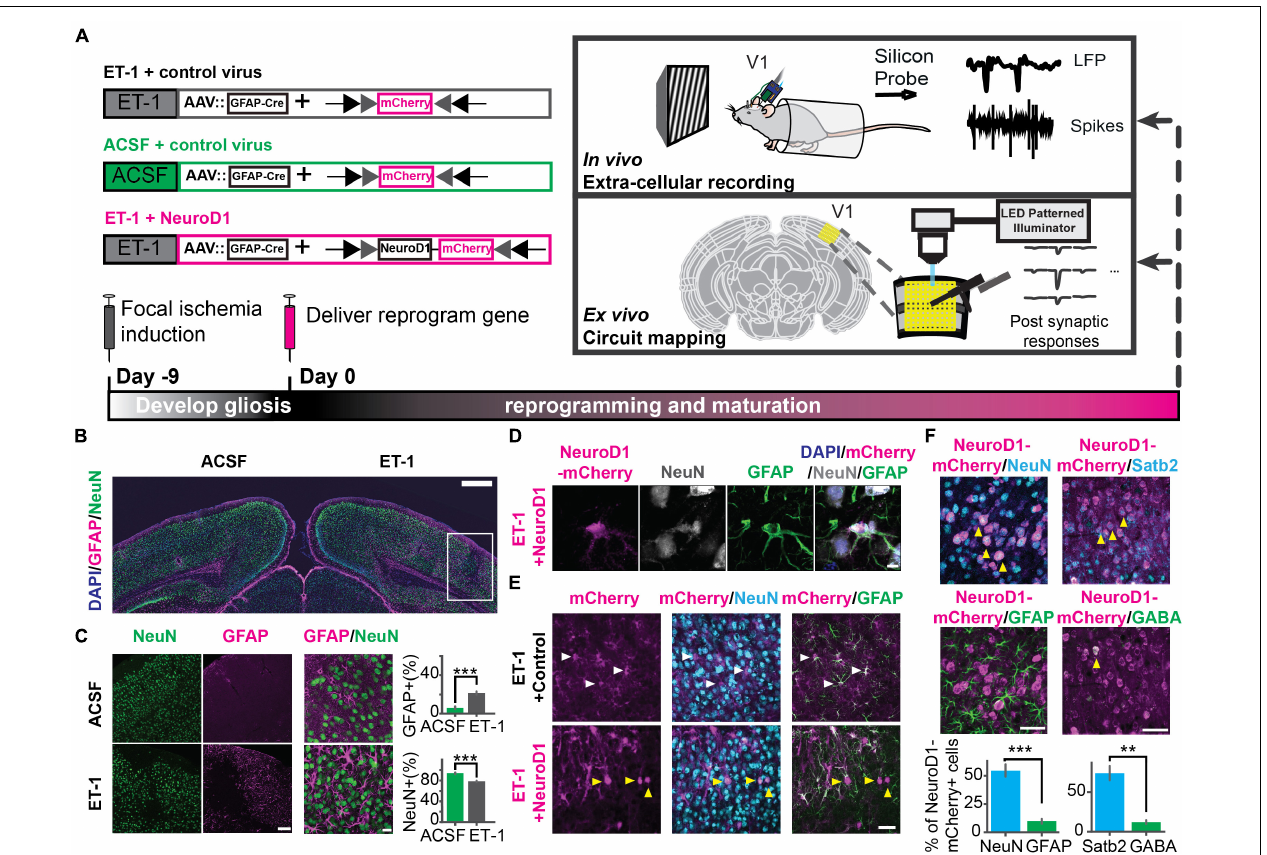
FIGURE 1 | Focal ischemic injury model and in vivo direct reprogramming in the primary visual cortex. (A) The schedule to induce focal ischemia by endothelin-1 (ET-1) injection and to reprogram astrocytes into neurons by injection of AAV-GFAP::Cre with AAV-FLEX-NeuroD1-mCherry (or with AAV-FLEX-mCherry as control). Following reprogramming, visual responses and local circuit connectivity of the primary visual cortex (V1) were assessed by in vivo extracellular recordings and ex vivo Channelrhodopsin-Assisted Circuit Mapping (CRACM). (B) Gliosis (GFAP, magenta) and neuronal loss (NeuN, green) at 9 days after 4 ug/ul ET-1 injection in the visual cortex. The box indicates injury site with gliosis and neuronal loss. Scale: 500 µ m. (C) Localized neuronal loss and gliosis at 9 days after 4ug/ul ET-1 injection. Scale left : 50 µ m. Scale right : 20 µ m. Right: Quantification of the percentages of GFAP-positive cells (top) and NeuN-positive cells (bottom). N ACSF = N ET − 1 = 3 mice, 9 slices. p = 4.12 × 10 − 4 , Mann-Whitney U test. (D) An example of NeuroD1-mCherry-positive cell undergoing a transition stage at 10 days after NeuroD1 delivery, expressing both GFAP and NeuN. Scale: 5 µ m. (E) mCherry positive cells co-stained with NeuN and GFAP at 10 days after viral injection. White arrows pointing to GFAP positive and NeuN negative cells. Yellow arrows pointing to GFAP negative and NeuN positive cells. Scale: 50 µ m. (F) NeuroD1-positive cells stained with NeuN, GFAP, Satb2, and GABA at 3 weeks after NeuroD1 delivery. Scale: 50 µ m. Bottom: Quantification of the ratios of marker positive cells. N NeuN / GFAP = 3 mice, 9 slices. p = 9.01 × 10 − 4 , Mann-Whitney U -test. N Satb2 / GABA = 2 mice, 6 slices. p = 5.08 × 10 − 3 , Mann-Whitney U -test. ** p < 0.01 and *** p < 0.001. Data are represented as mean ± SEM. See also Supplementary Figures 1, 2